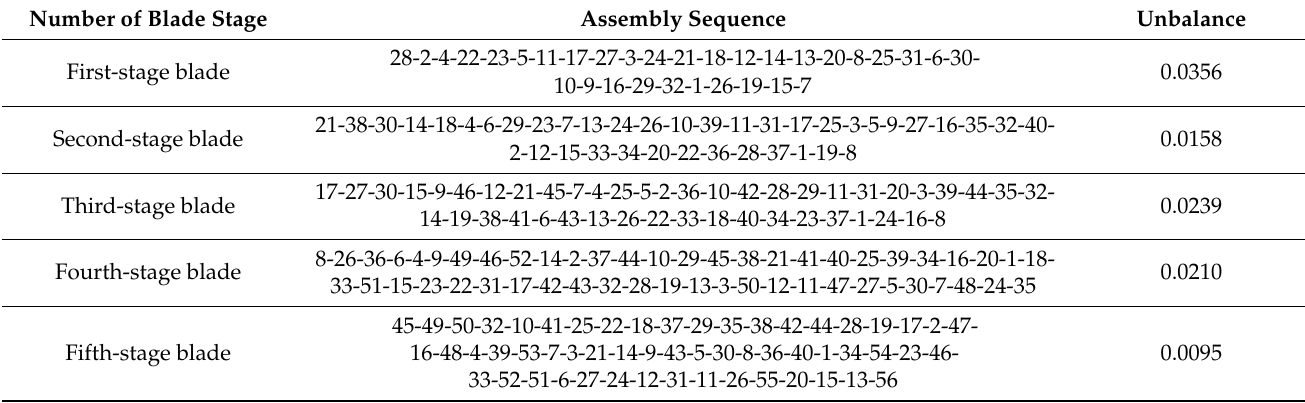
Table 7. Improve the IHHO assembly sequence of each stage of disc